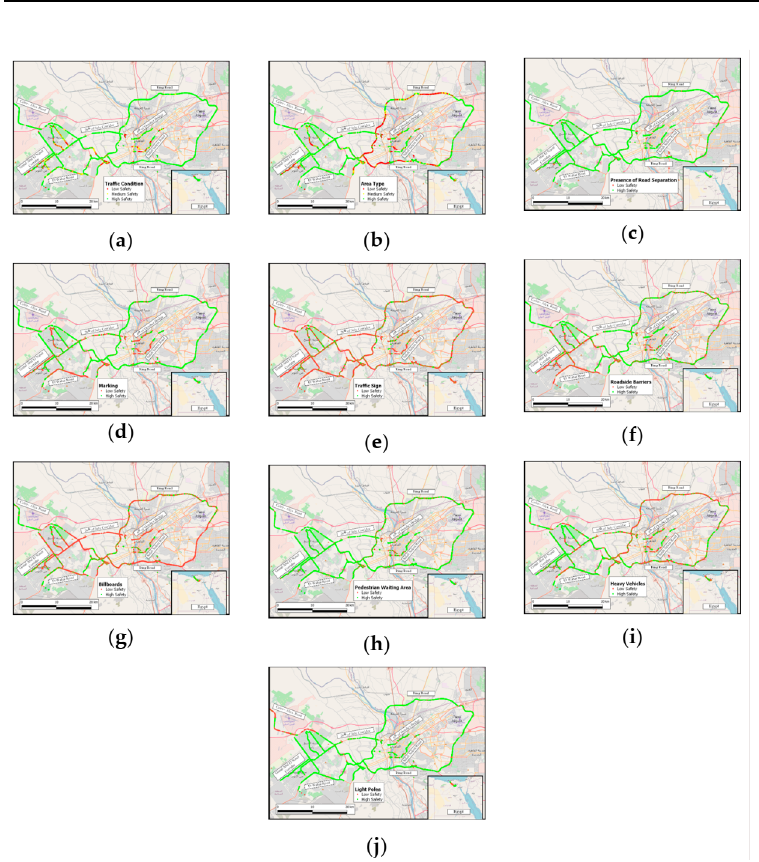
Figure 6. Automatically detected roadway features maps for: ( a ) traffic condition, ( b ) area types, ( c ) road separation, and presence of ( d ) marking, ( e ) traffic signs, ( f ) roadside barrier, ( g ) billboard, ( h ) pedestrian waiting area, ( i ) heavy vehicles, ( j ) and light